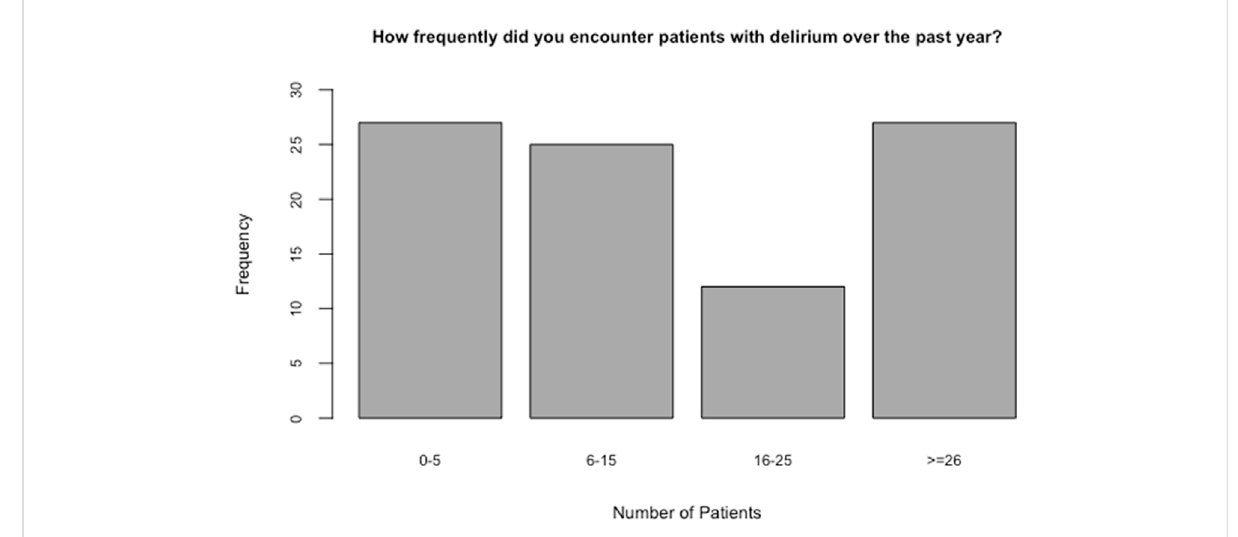
FIGURE 3 Delirium patients ’ seen by healthcare providers in a year (frequency of delirium